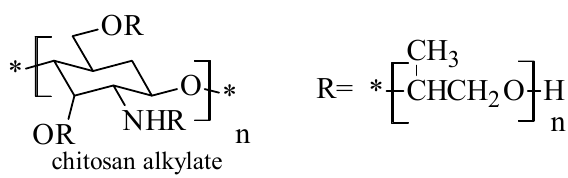
Figure 5. Hydroxypropyl derivatives of chitosan.